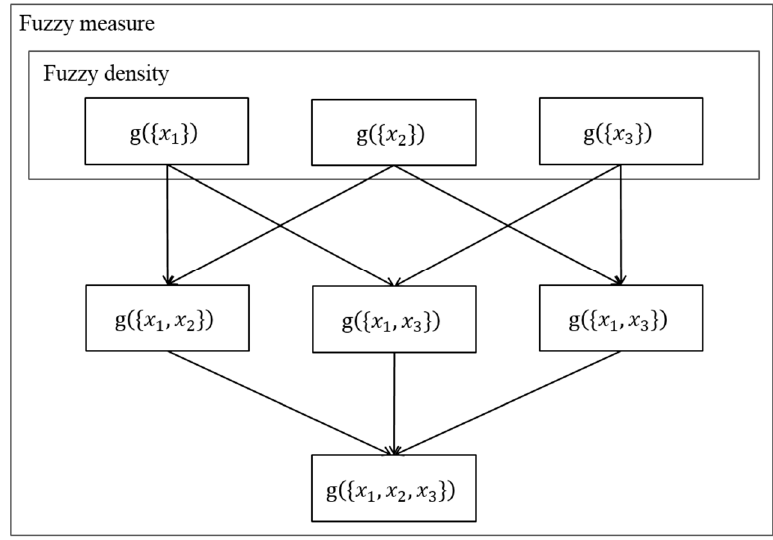
Figure 4. Relation between fuzzy measure and fuzzy density.